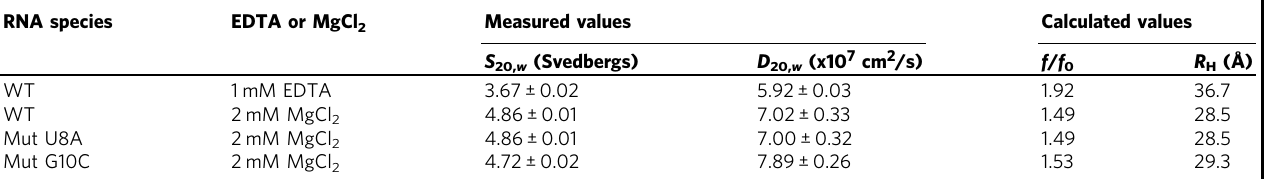
Table 1 Sedimentation velocity analytical ultracentrifugation measurements RNA species